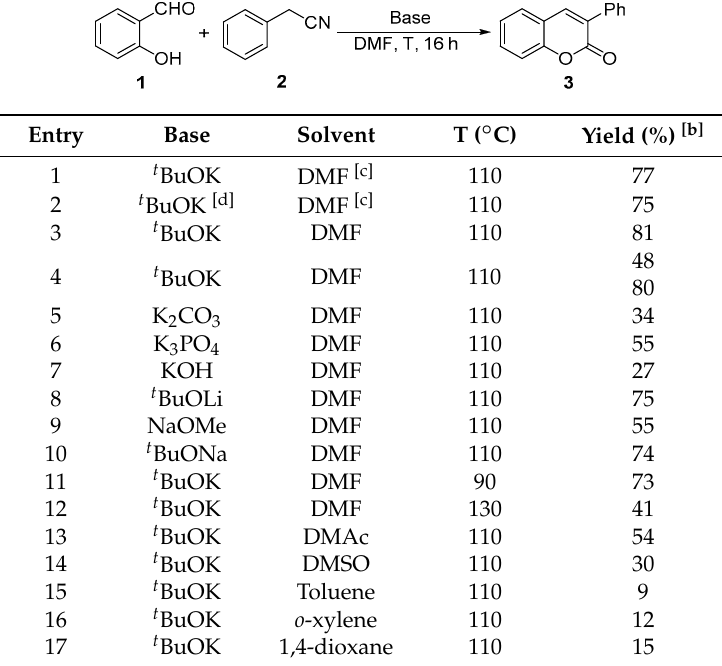
Figure 1. Selected examples of bioactive chromenones.